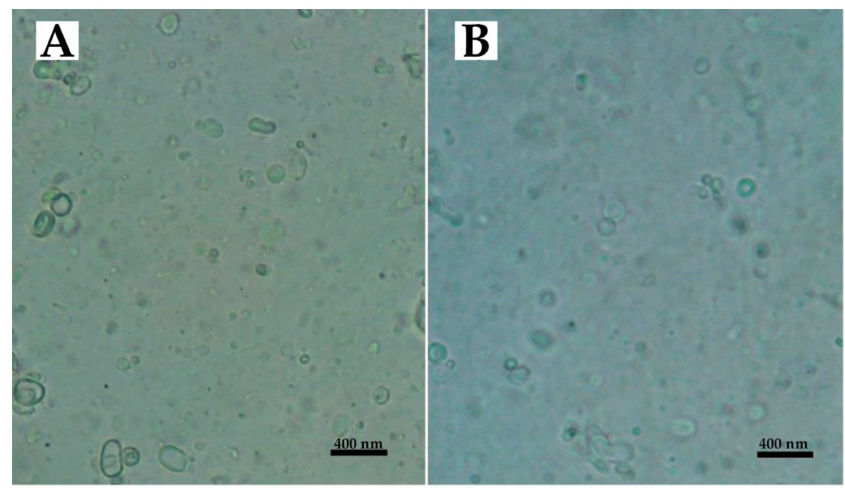
Figure 1. Light microscopy of ( A ) LCispt and ( B ) PLCispt.